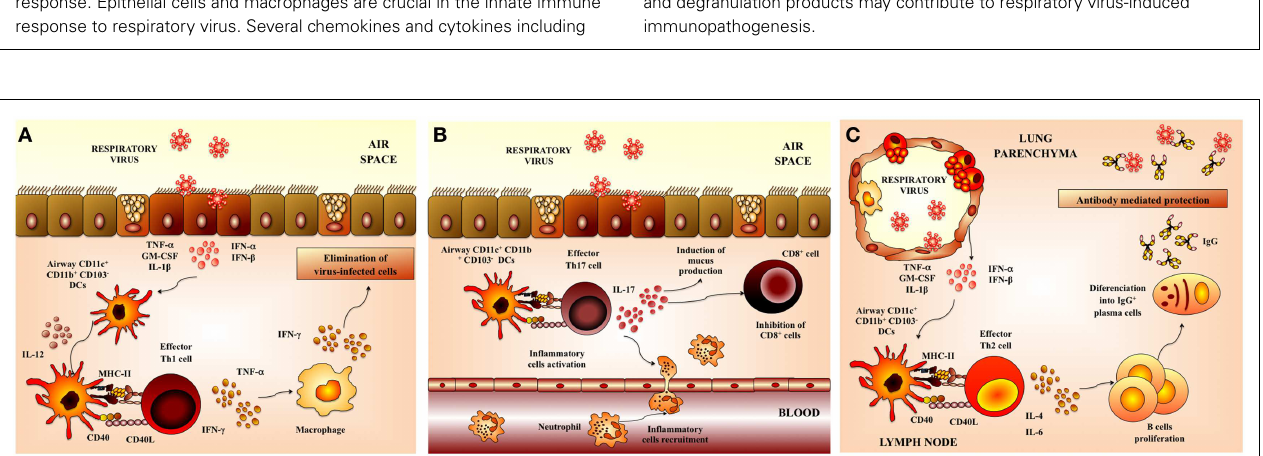
FIGURE 3 | Respiratory anti-viral adaptive immune response . (A) Th1 cellular immunity. Upon respiratory virus infection of lungs, CD11b + and CD103 + dendritic cells (DCs) are matured and migrate to the draining lymph nodes.These DCs primeTh1 cells that return to the lung and promote viral clearance. (B) Th17 cellular immunity.Th17 cells produce IL-17 that co-operates with IL-1 β andTNF- α to induce the release of chemokines.These